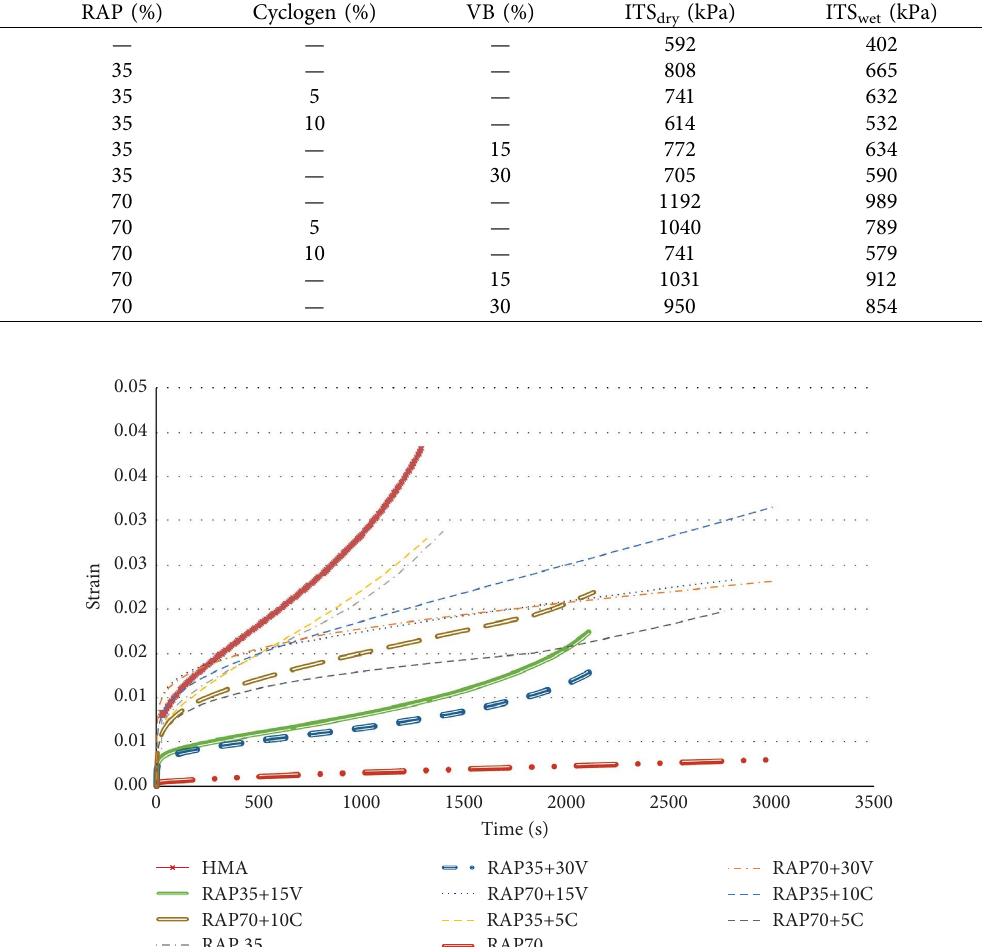
Figure 4: Creep curve for HMA and RAP mixtures with diferent amounts of rejuvenating